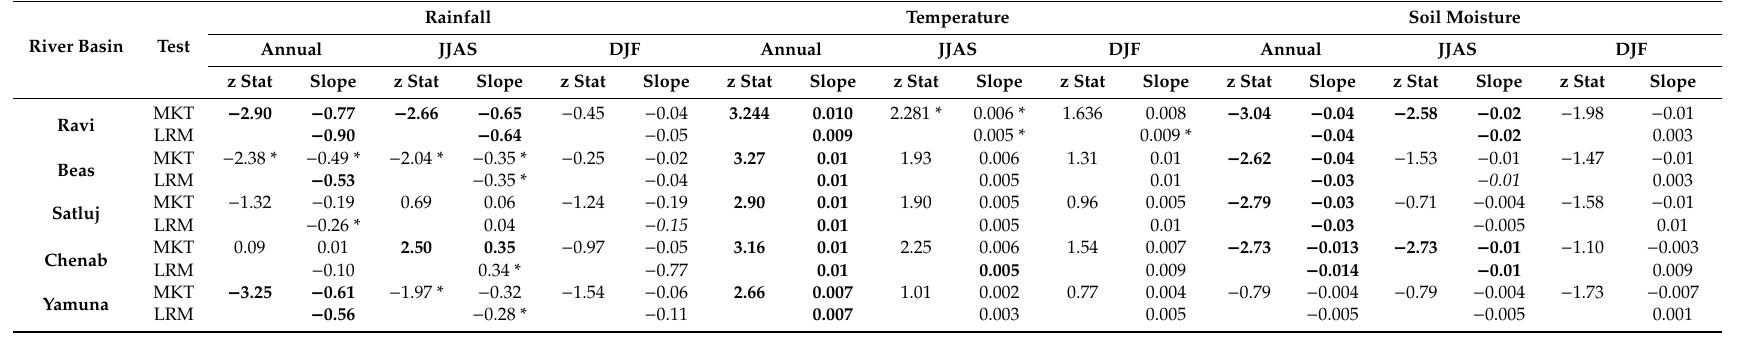
Table 2. Trend results for the Ravi, Beas, Satluj, Chenab, and Yamuna river basins. Results are based on the Mann–Kendall test (MKT) and Linear Regression Model (LRM). Values in italic represent 90% significance level, * represents 95% significance level, and values in bold are significant at 99%. All the results are for the period